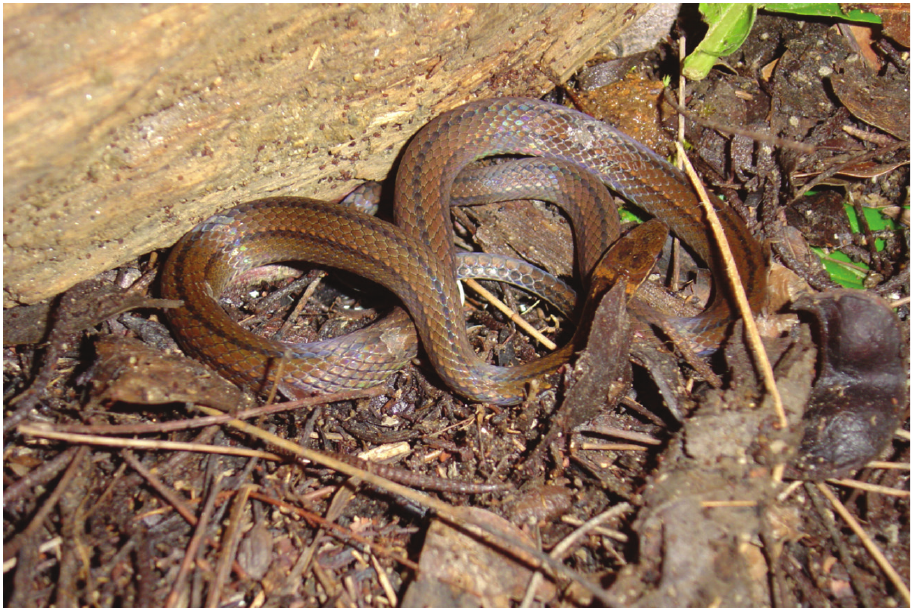
Figure 3. Rhadinaea nuchalis sp. n., holotype (MZFC-HE 22161) in life.